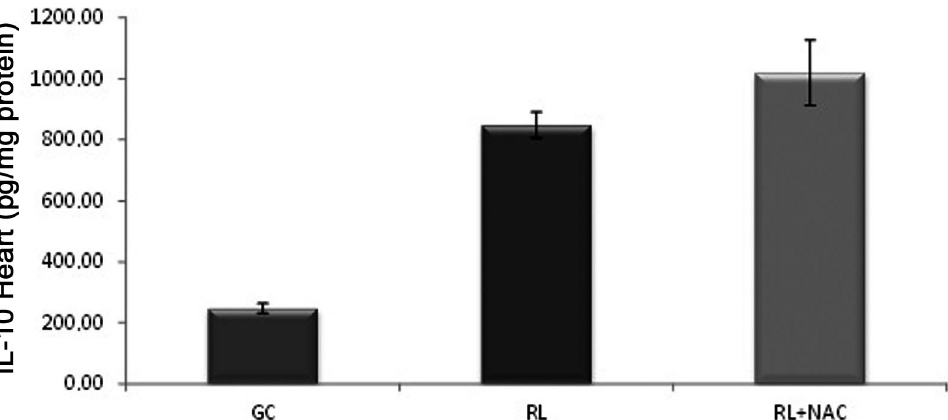
Fig. 3 - Interleukin 10 expression in cardiac tissue for the control group (CG), Ringer Lactate group (RL) and Ringer lactate with N-acetylcysteine group (RLNAC). * Significant difference when compared to CG,